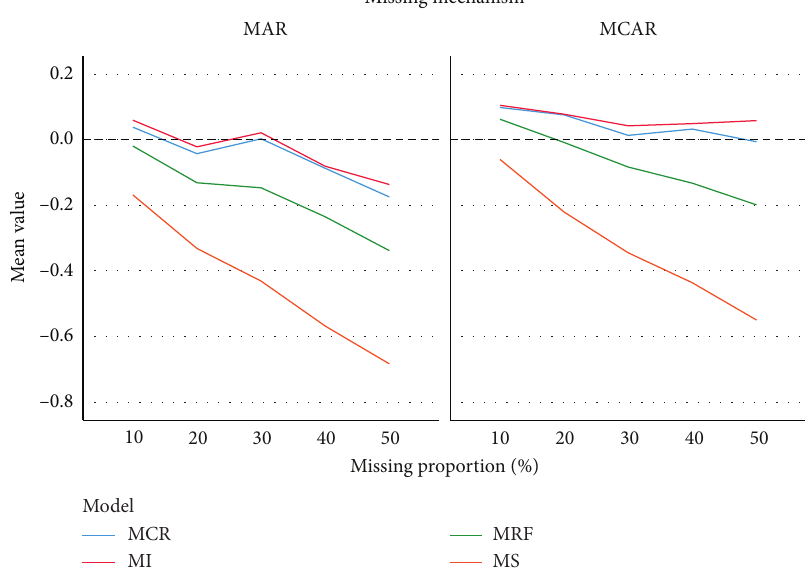
Figure 2: Comparison of the performance of imputation methods for real dataset based on the average percent bias (PB) for the interaction effect. MAR, missing at random; MCAR, missing completely at random; MCR, multiple imputation by chained equation using classification and regression trees; MRF, multiple imputation by chained equation using random forests; MI, MICE-Interaction method; MS, MICE- Stratified method.